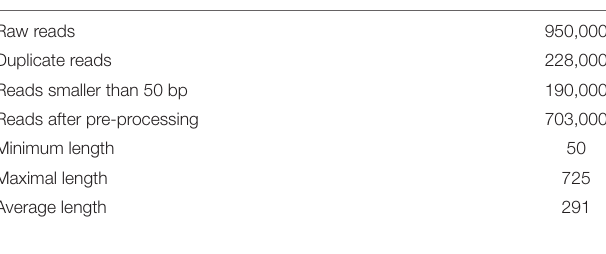
TABLE 1 | Summary of raw and pre-processed reads.